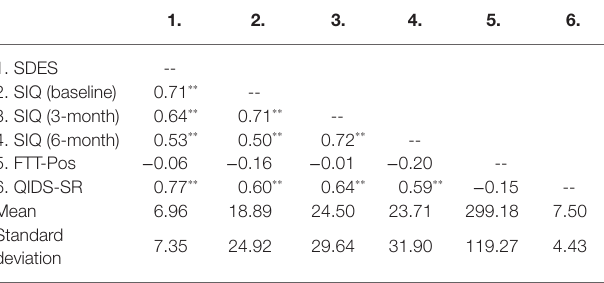
TABLE 1 | Bivariate correlations and descriptive statistics.